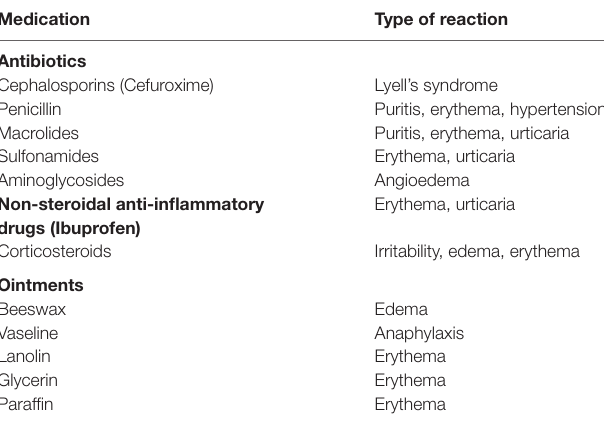
taBle 1 | List of medications and the type of allergic